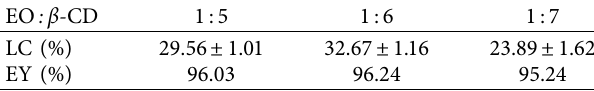
Table 1: LC and EY of microencapsulated EOs 1